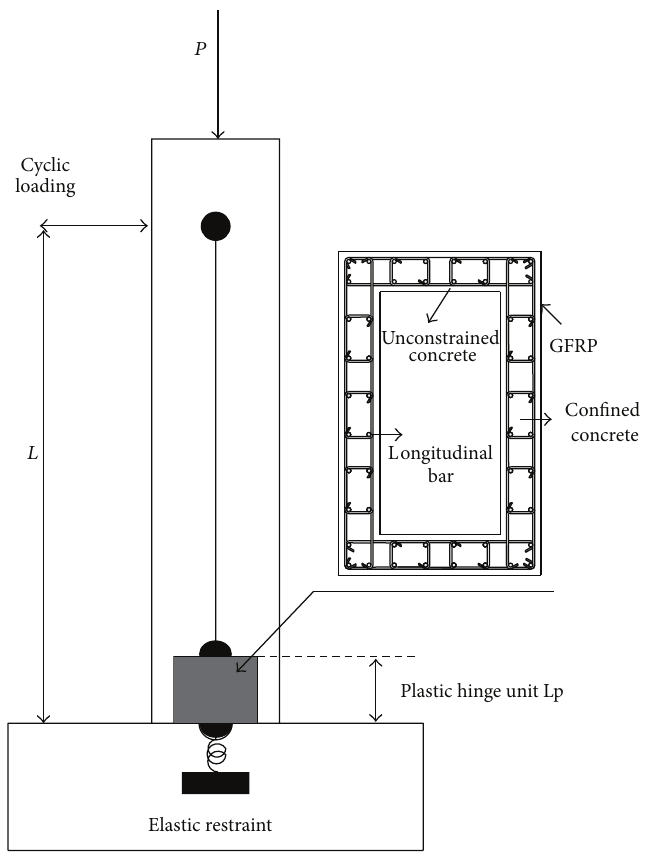
Figure 8: Analytical